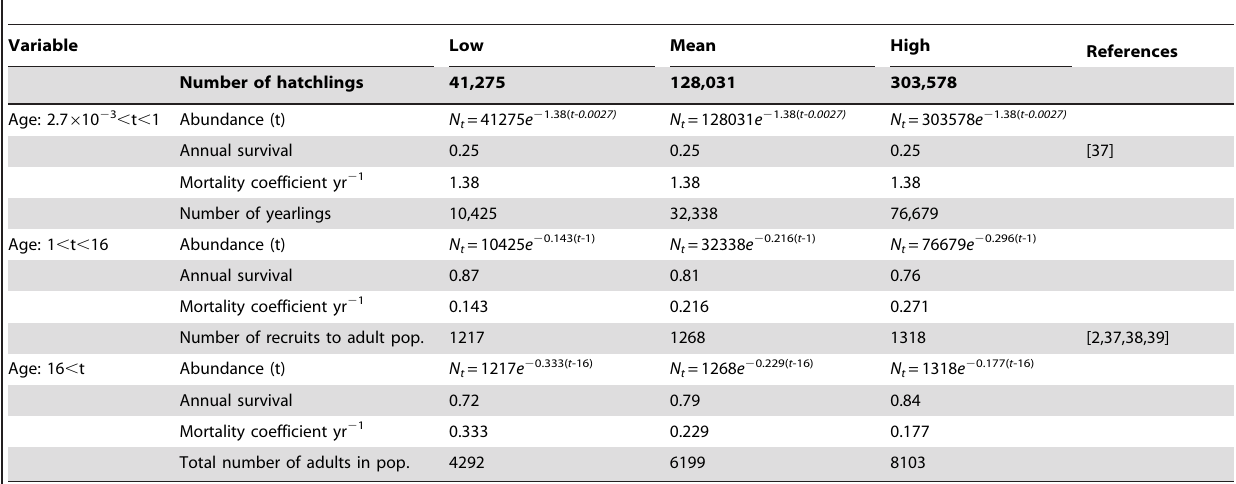
Table 2. Computation of turtle abundance, survival, and related parameters based on estimates of hatchling production, new recruits, and sex ratios from the literature.